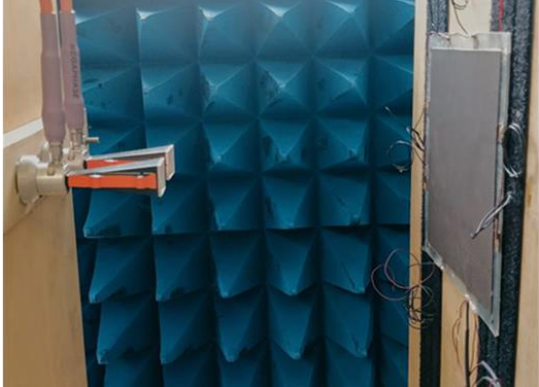
Figure 18. Set-up for the reflection coefficient measurement of the SEAL.